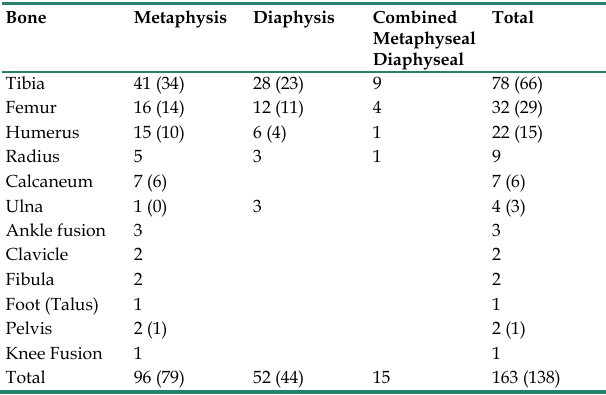
Table 1. Location of Chronic Osteomyelitis treated in each case. Bone